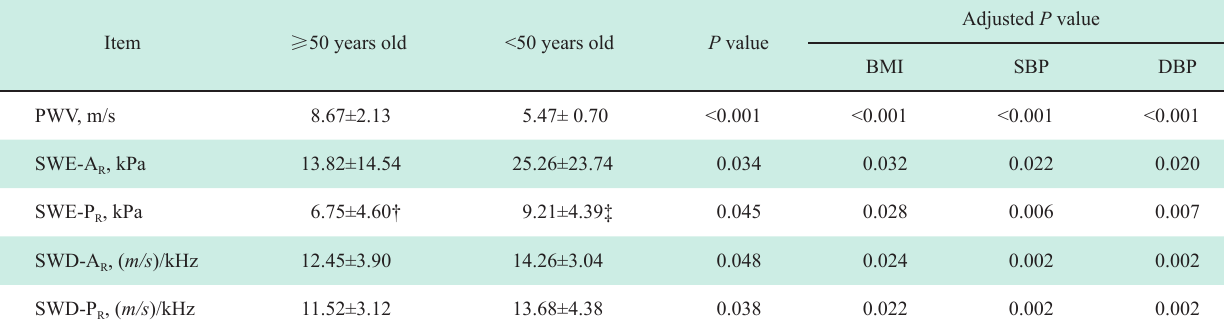
Table 2 Comparison of carotid structure, elastic modulus and viscoelasticity index between the two groups ( Mean± SD